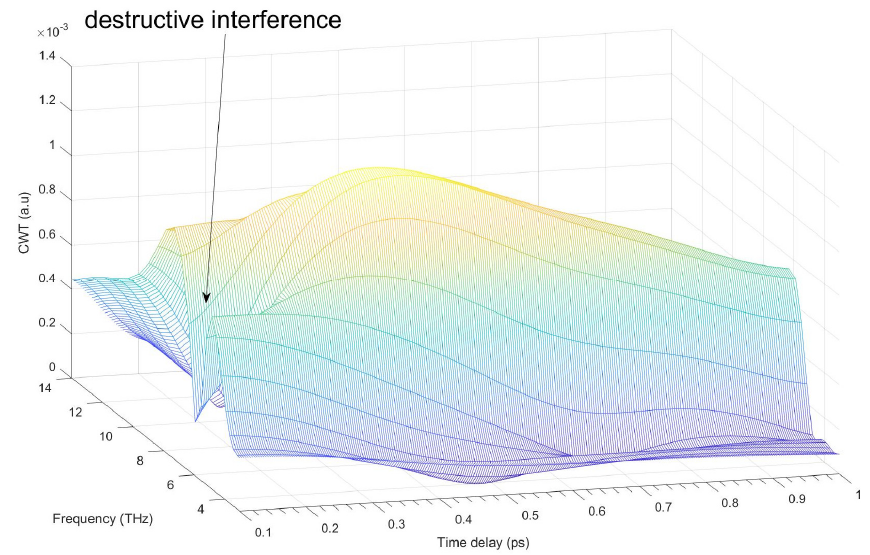
Figure 7. Destructive interference. Spectrogram calculated by CWT corresponding to the transient trace at 567 nm measured at the pump fluence of 0.18 mJ/cm 2 . The 3D plot shows a frequency region around the oscillation of the coherent LO phonon.